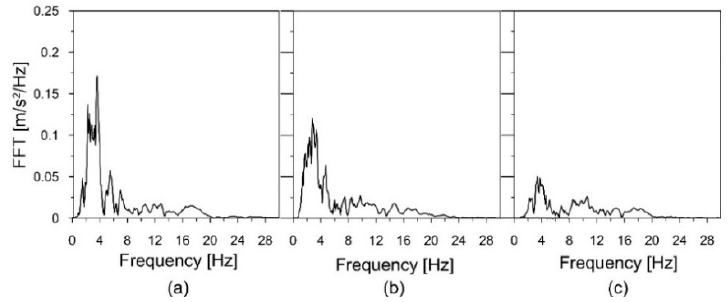
Figure 2. The frequency spectra of the acceleration up to 30 Hz registered in the USCB region: ( a ) horizontal direction WE; ( b ) horizontal direction NS; ( c ) vertical direction Z.